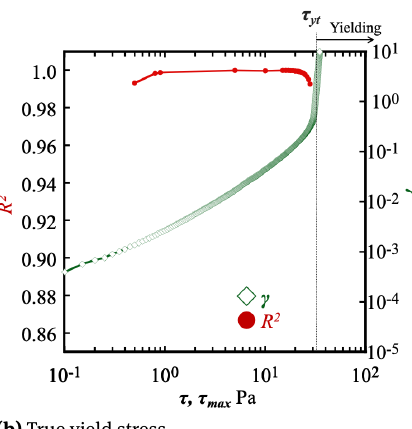
The strain required to determine the slip and true yield points was obtained by fitting the results of the